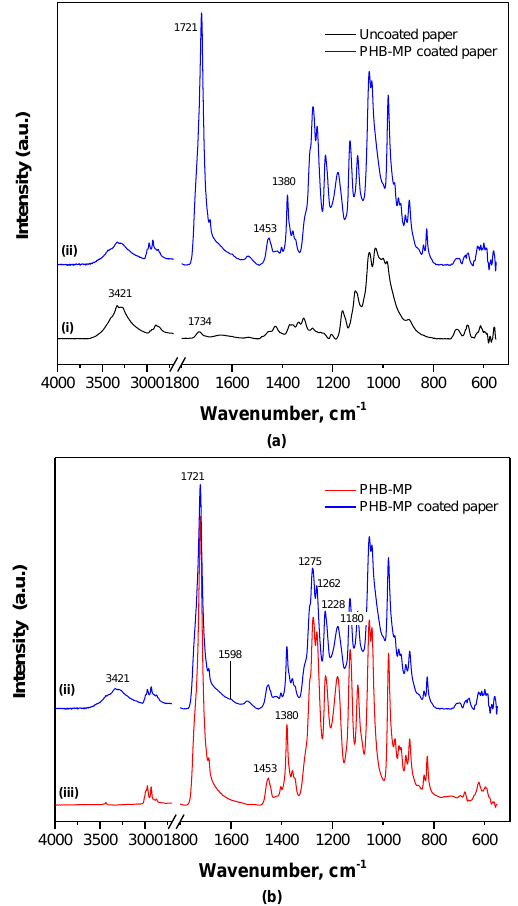
Figure 6. FTIR spectra showing the interactions between PHB-MP and cellulose fibers of the paper substrate: ( a ) spectra normalized over non-overlapped region, 730–645 cm −1 ; ( b ) spectra normalized over the PHB insensitive crystalline band, 1453 cm −1 , for (i) uncoated filter paper, (ii) PHB-MP coated paper and (iii) PHB-MP powder.